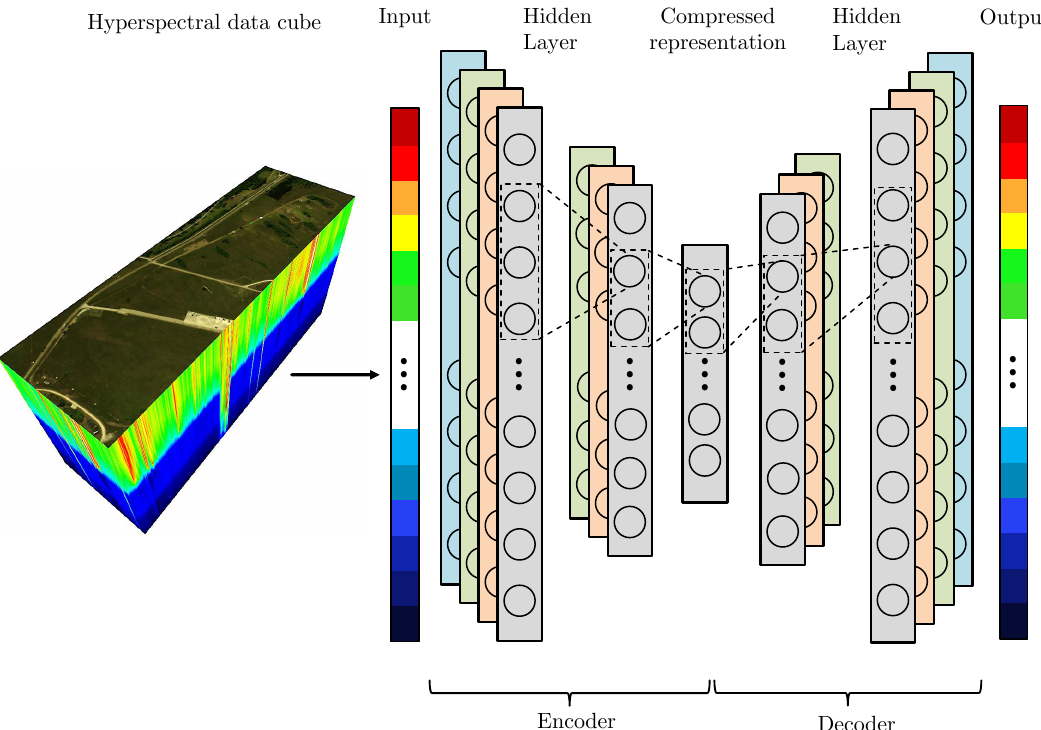
Figure 1. Individual spectral sigature from the 3D hyperspectral data cube are supplied to the 1D-CAE. In the hidden layer, several filters, shown in different colors, are used in parallel to find features and extract them. The goal is to transform the input